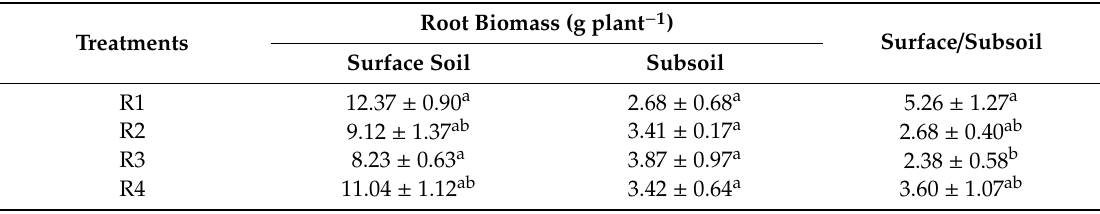
Table 3. E ff ects of red clay on maize root biomass in surface soil and subsoil. Di ff erent lowercase letters indicate significant di ff erences among the di ff erent